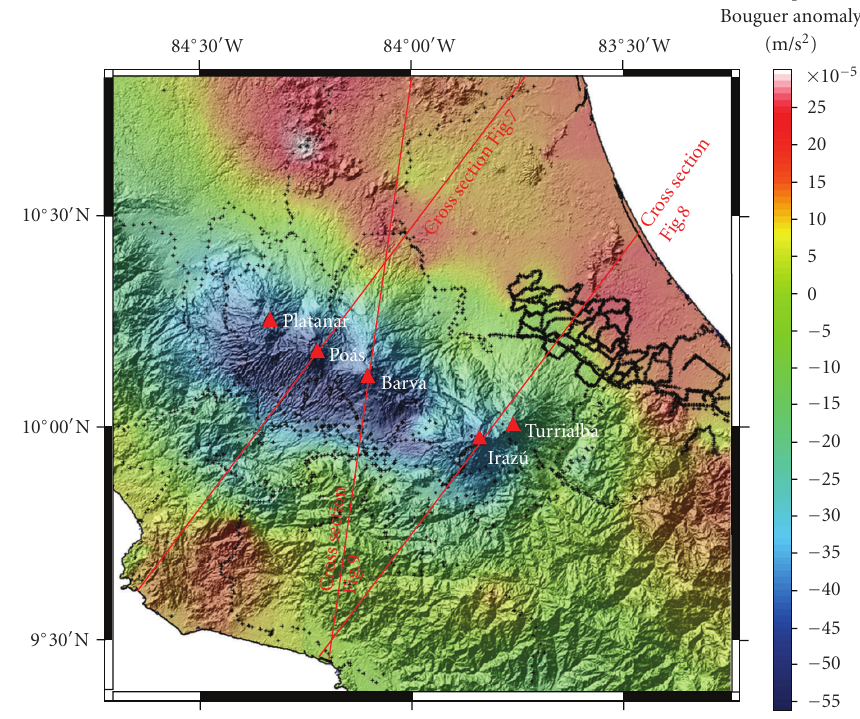
Figure 2: Complete Bouguer anomaly map of central Costa Rica draped over the shaded SRTM [7] relief map. Red triangles show location of the main Quaternary volcanic vents. Black plus signs indicate the location of gravity stations. Red lines show locations of vertical cross sections presented on this